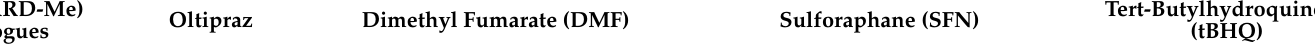
Table 1. Cont. Bardoxolone Methyl (BARD-Me) and Associated Analogues